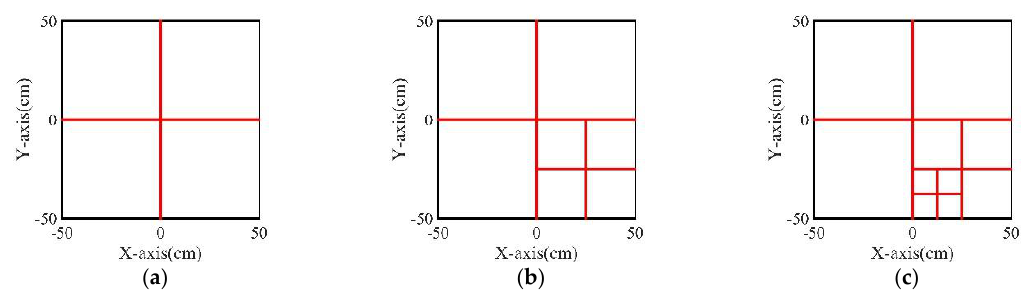
Figure 3. Schematic diagram of the test plate grid division: ( a ) first-stage division; ( b ) second-stage division; ( c ) third-stage division.